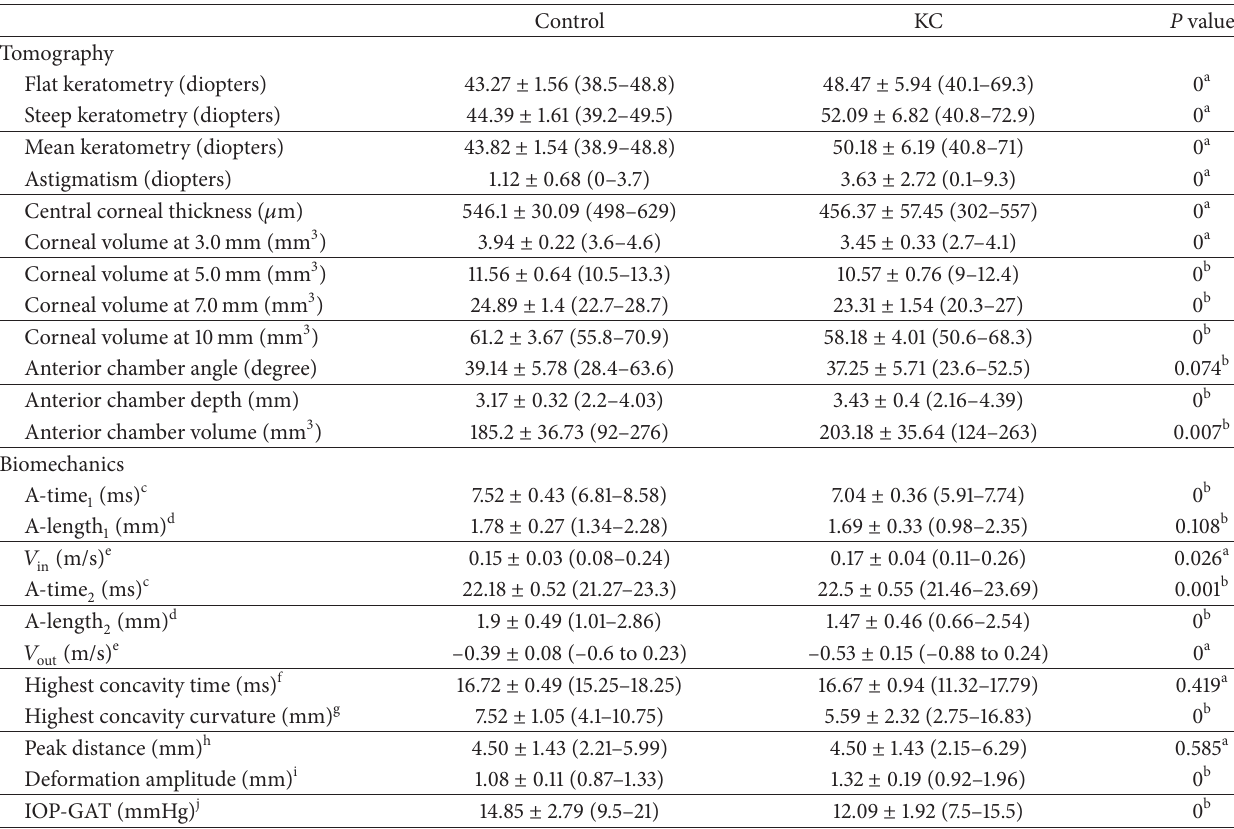
Table 1: Comparison of tomography and biomechanical parameters between the KC and control group, mean ± SD (range).